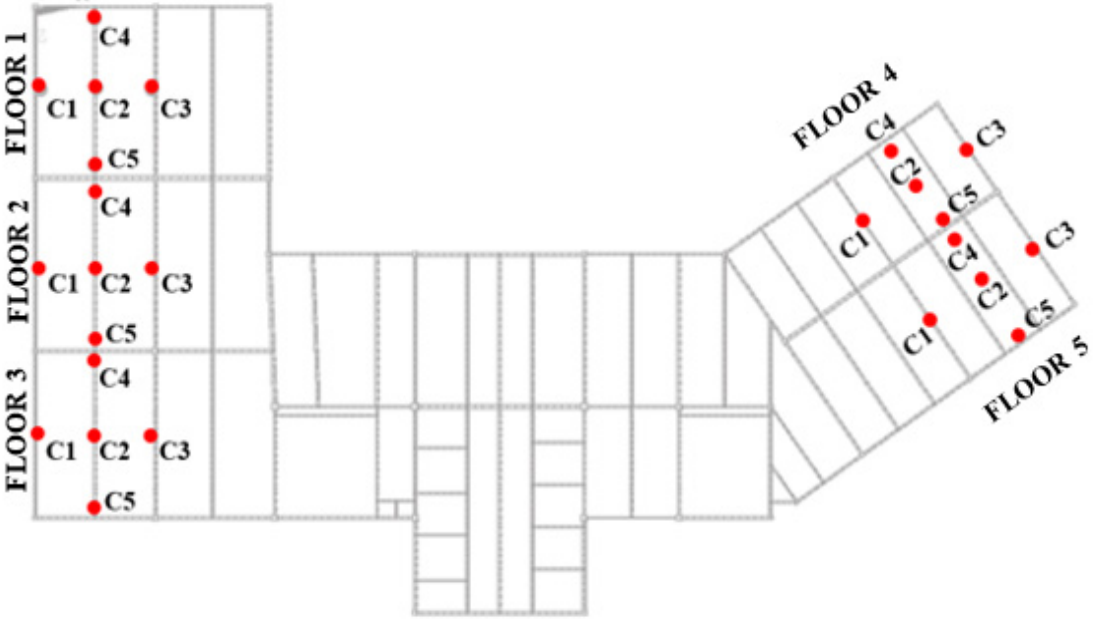
Figure 5. Instrumentation points over the five tested floors.